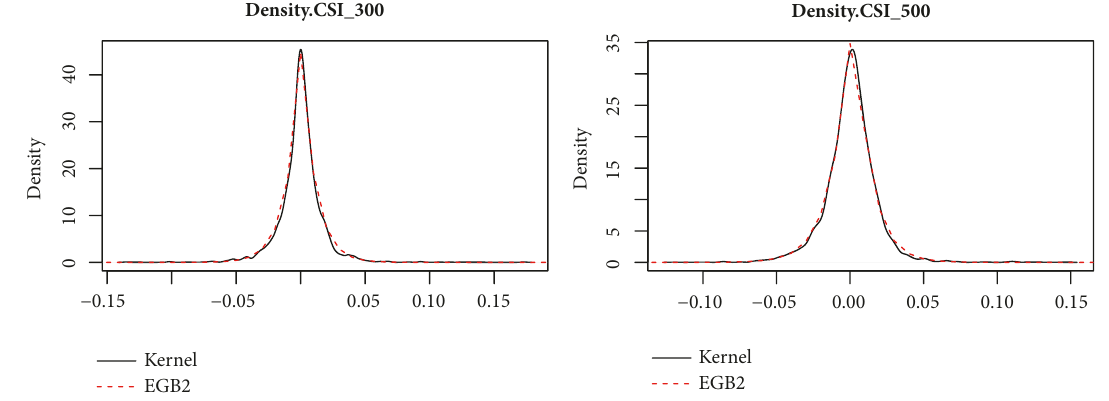
Figure 2: Fitting effect of EGB2 distribution as marginal distribution.